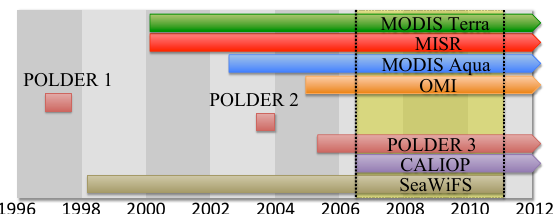
Fig. 1. Periods of operation of major past and current aerosol- measuring satellite sensors. The pair of dotted vertical lines marks the “golden” period (between the start of CALIOP in July 2006 and the end of SeaWiFS in December 2010) when as many as seven of these sensors were measuring aerosols concurrently. The golden pe- riod was used as the base for the studies reported in the rest of this